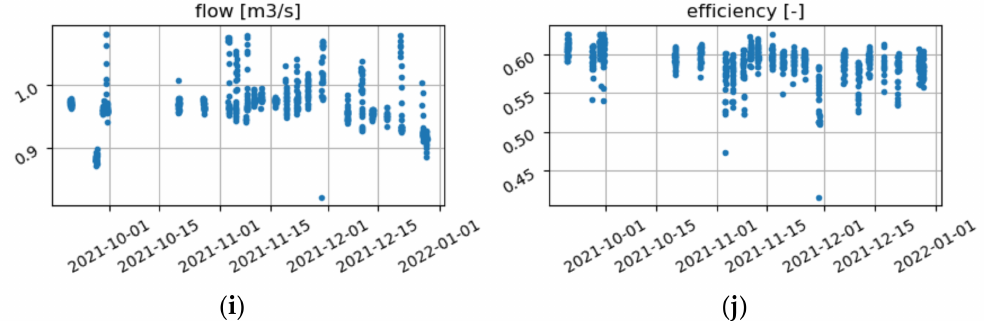
Figure 3. Measurement points from selected days used to develop a mathematical model, where: ( a ) suction temperature ( ◦ C), ( b ) discharge temperature ( ◦ C), ( c ) suction pressure (Pa), ( d ) discharge pressure (Pa), ( e ) flow (V), ( f ) current consumption (A), ( g ) rotation speed (Hz), ( h ) humidity (%), ( i ) flow (m 3 /s), ( j ) efficiency (-).